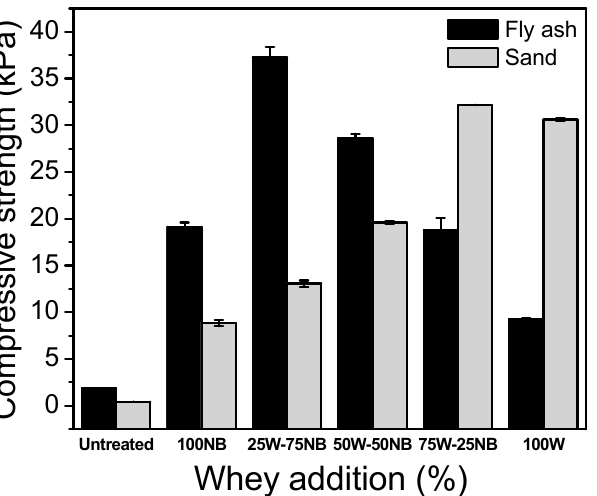
Figure 6. Compressive strength of sand and fly ash treated with different whey additions.